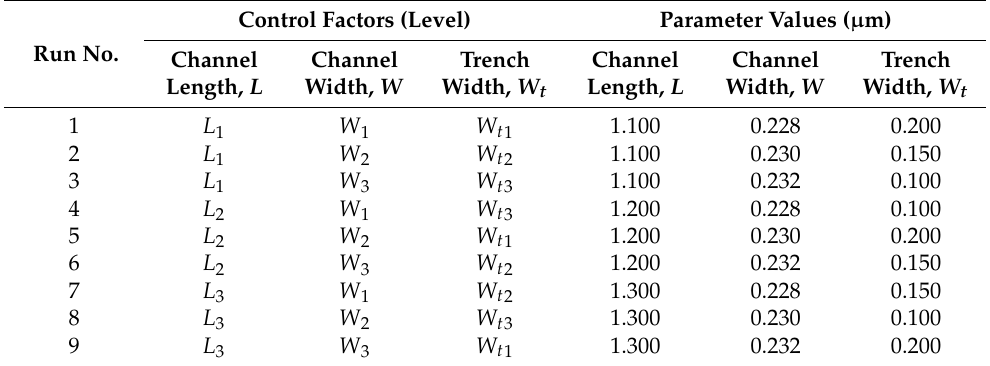
Table 2. DOE using selected control factors and their level parameters for SSD optimization.